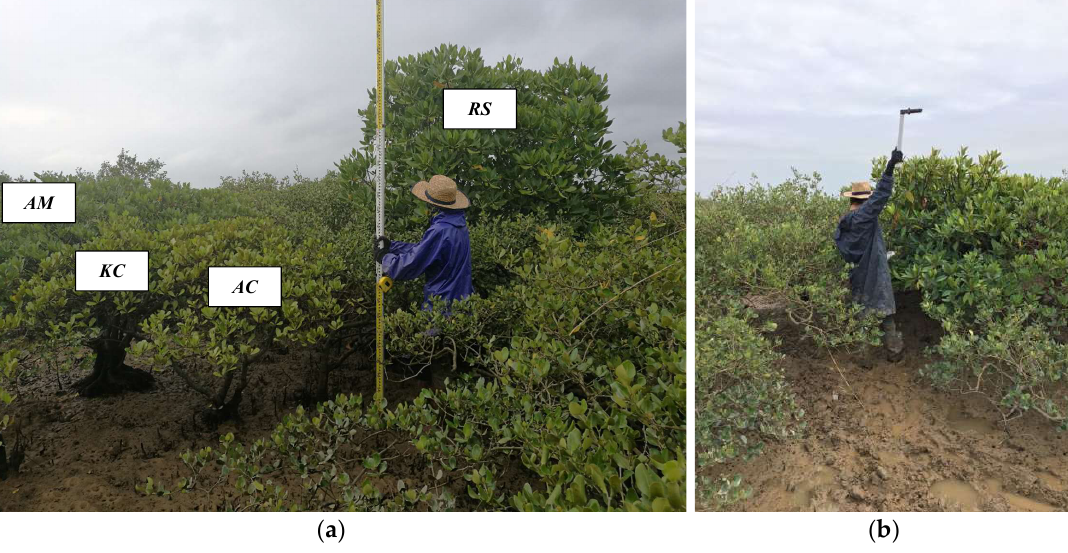
Figure 1. ( a ) Four species of mangrove in the study area; ( b ) Researcher is acquiring field-measured leaf area index (LAI) data at plot scale with the radius of 5 m by the LAI-2200 Plant Canopy Analyzer.